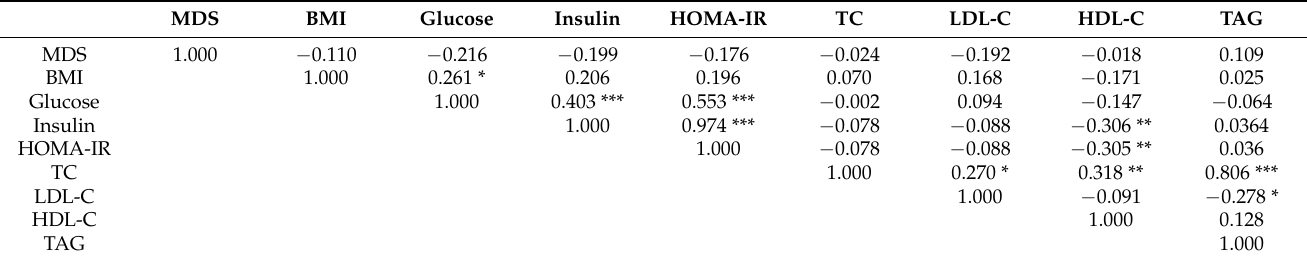
Table 5. Associations MDS and cardiometabolic and anthropometric